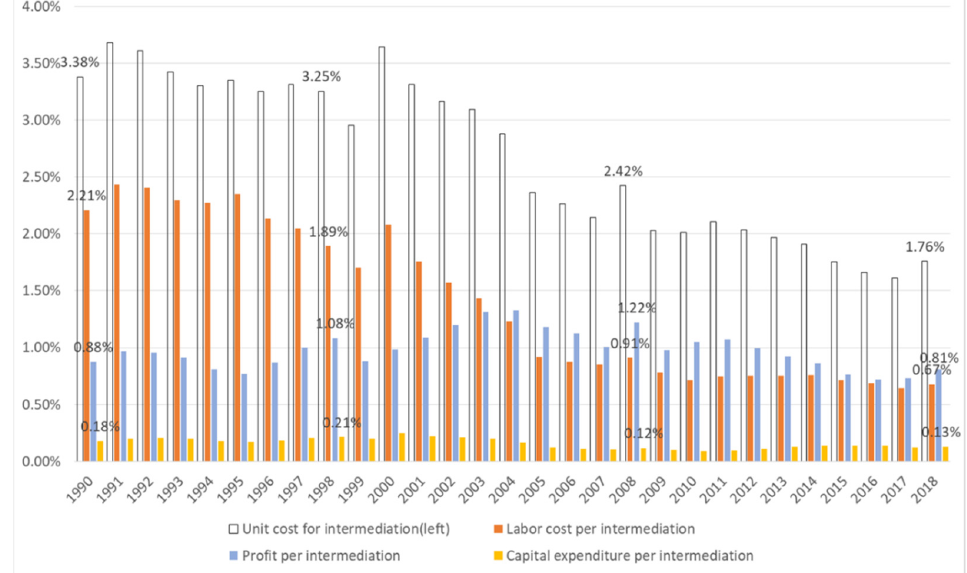
Figure 4. Unit cost per intermediated asset by components. Source: Author compilation quoted in (Bank of Korea 2020; Korea Statistics Information System (KSIS) 2021).